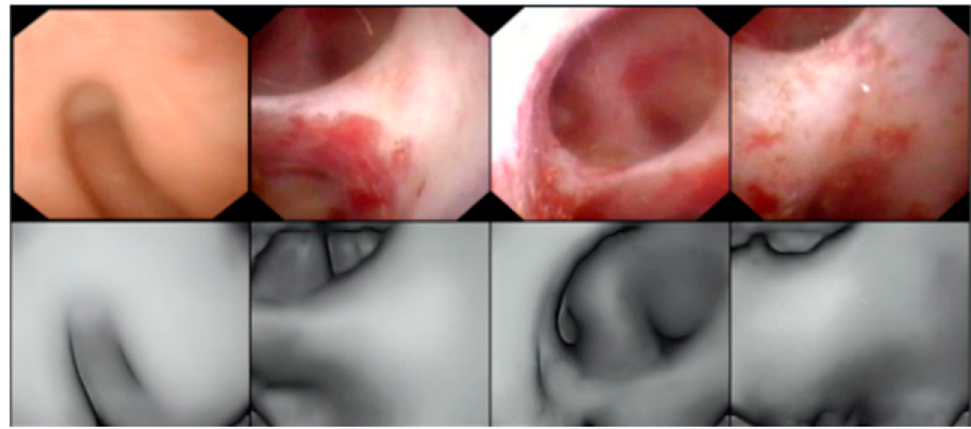
Figure 8. Examples of style transfer results. The first row represents the ureteroscopy images, and the second row represents the results of the style transfer.